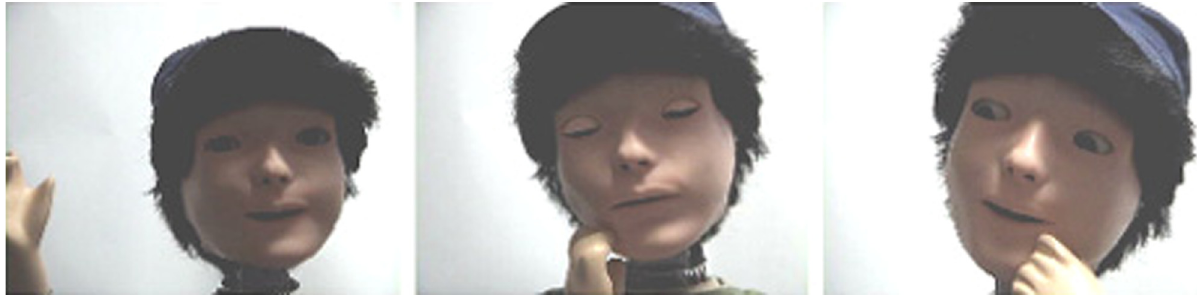
Figure 2: Some of Kaspar ’ s